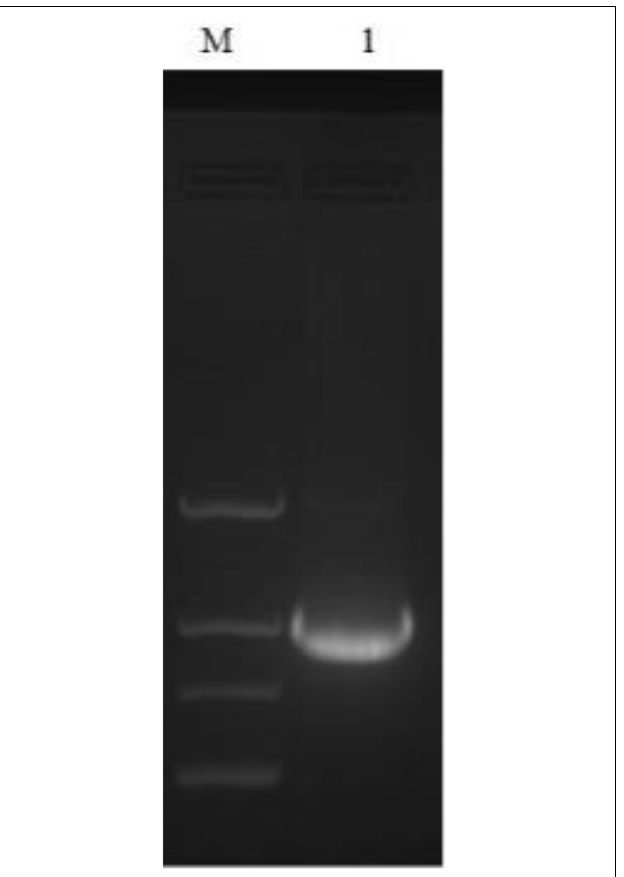
FIGURE 9 | PCR amplification of positive yeast colony. M indicated DL 2000 marker, 1 indicated PCR amplification of positive yeast colony using primers 30a-wri1(CF) and 30a-wri1(CR).